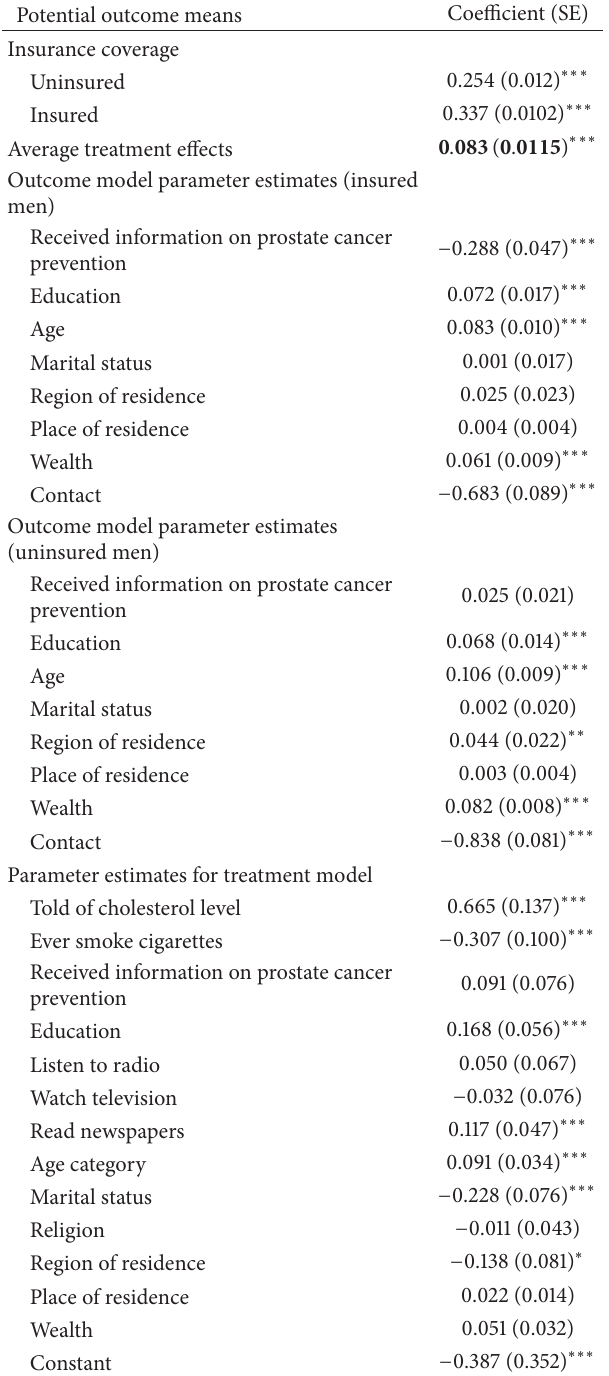
Table 4: Average effects of insurance coverage using augmented inverse probability weighting.